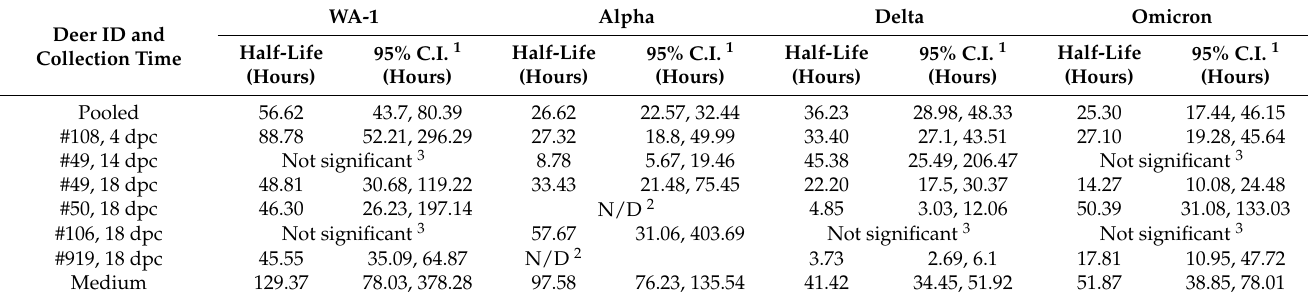
Table 3. The half-life values of SARS-CoV-2 WA-1 strain and different variants of concern in 10% fecal suspension of white-tailed deer under winter